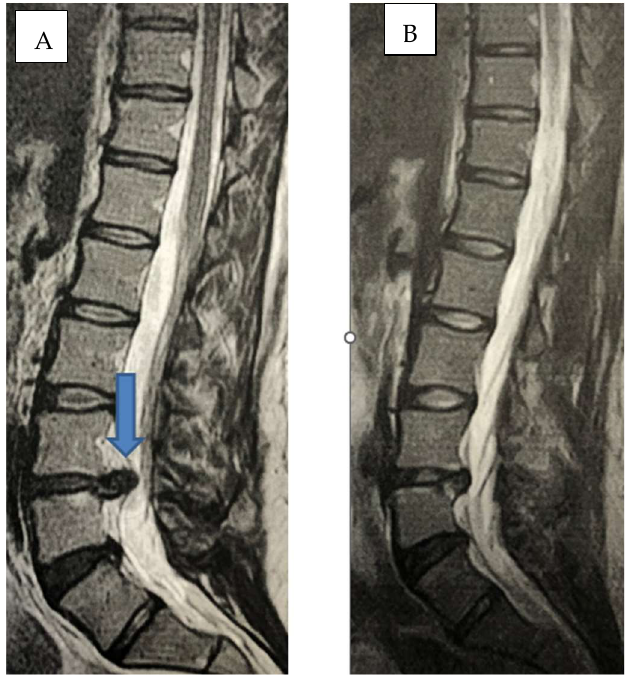
Figure 6. ( A , B ): Sagittal MR scan before (arrow) and after oxygen-ozone + ALA + PEA + Myrrh, herniated disc in L4-L5 (arrow), complete dehydration after treatment. Periganglionic steroid treatment using CT-guided paraspinal infiltration was effective in relieving root pain caused by spondylosis or herniated disc but was short- lived.